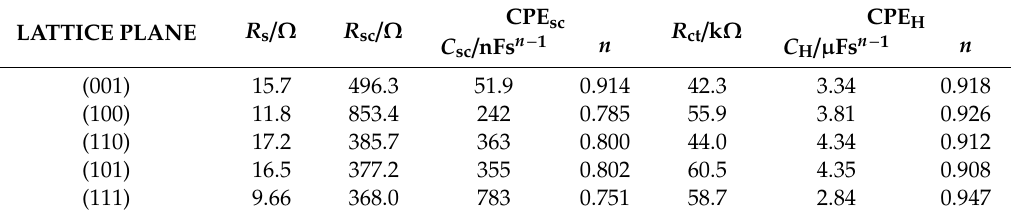
Table 2. Fitted parameters of the Nyquist plots for single-crystal TiO 2 :Nb photoanodes. LATTICE